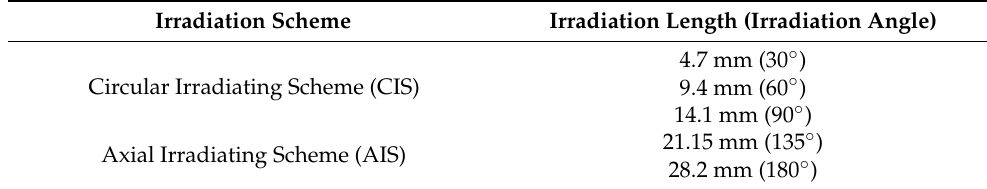
Figure 3. The schematics of the circular irradiating scheme (CIS) and axial irradiating scheme (AIS).